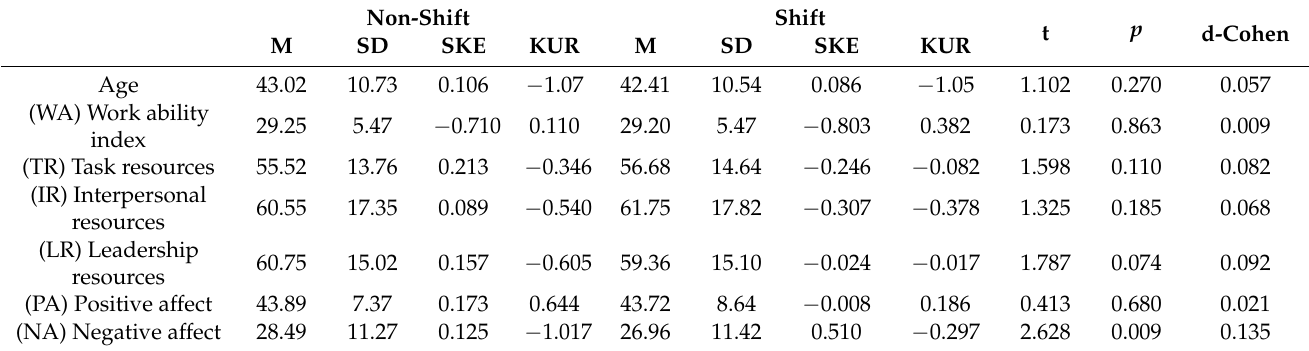
Table 2. Descriptive statistics and comparative analysis in non-shift group vs. shift group.